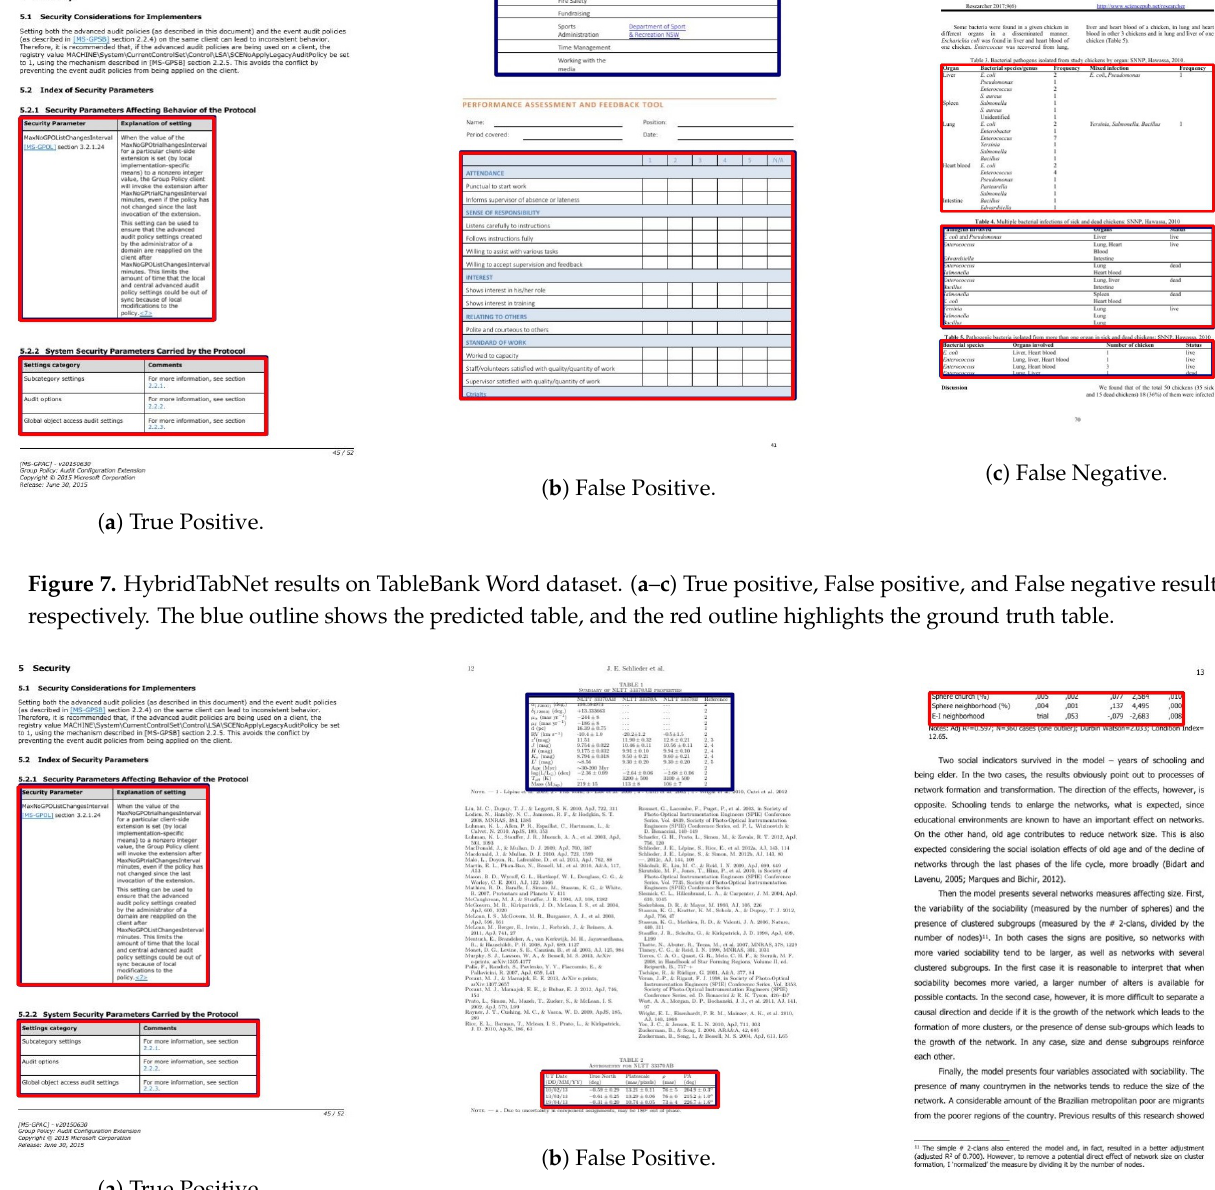
( b ) False Positive. ( a ) True Positive. ( c ) False Negative. Figure 8. HybridTabNet results on TableBank Both (Latex + Word) dataset. ( a – c ) True positive, False positive, and False negative results, respectively. The blue outline shows the predicted table, and the red outline highlights the ground truth